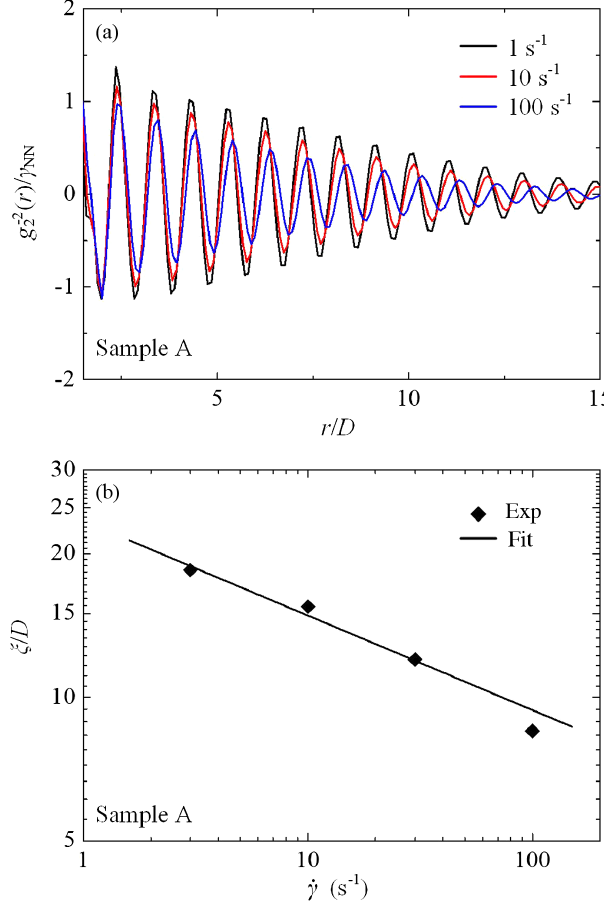
γ . (b) The 2 ð r Þ is normalized by NN